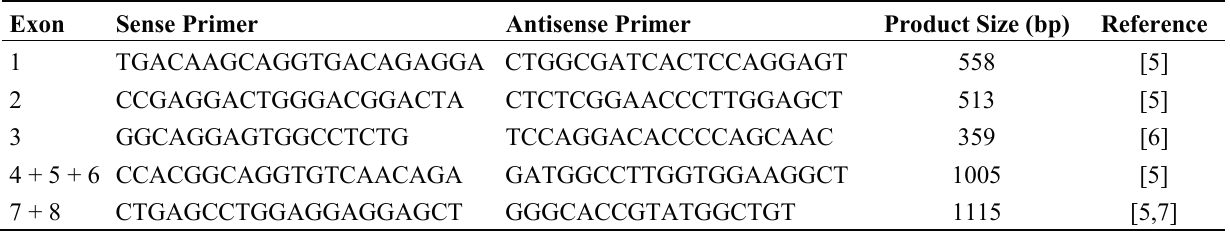
Table 2. Primer Sequences for LMX1B Amplification from Human Genomic